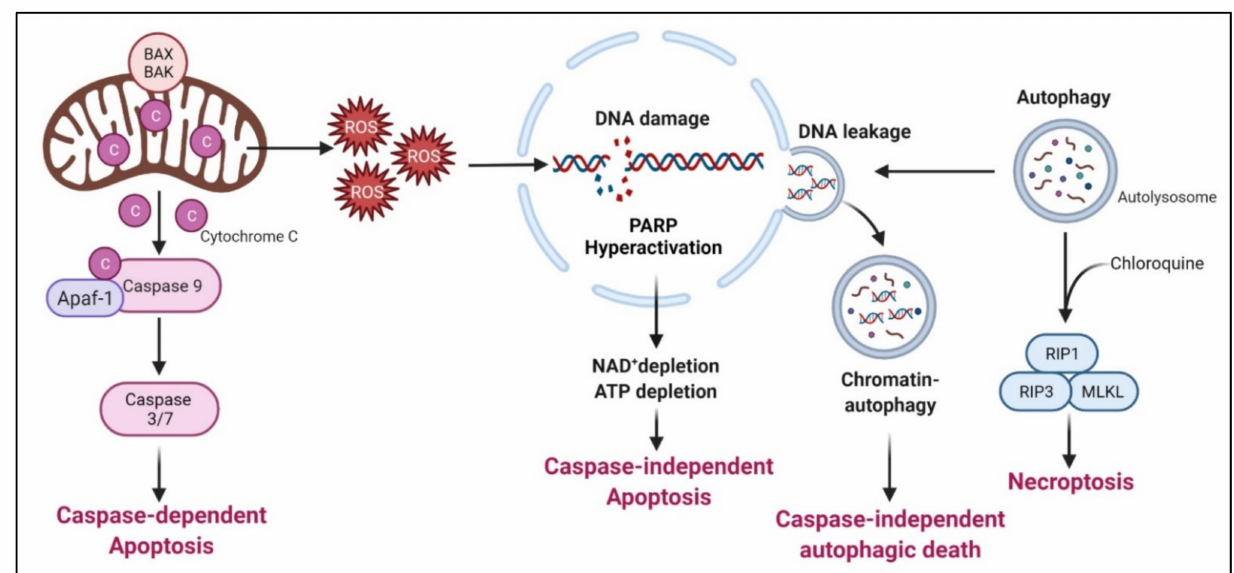
Figure 5. Arginine deprivation-induced types of cell death. The general cell-killing mechanisms by arginine depriva- tion include caspase-dependent apoptosis, caspases-independent apoptosis, caspase-independent autophagic cell death and